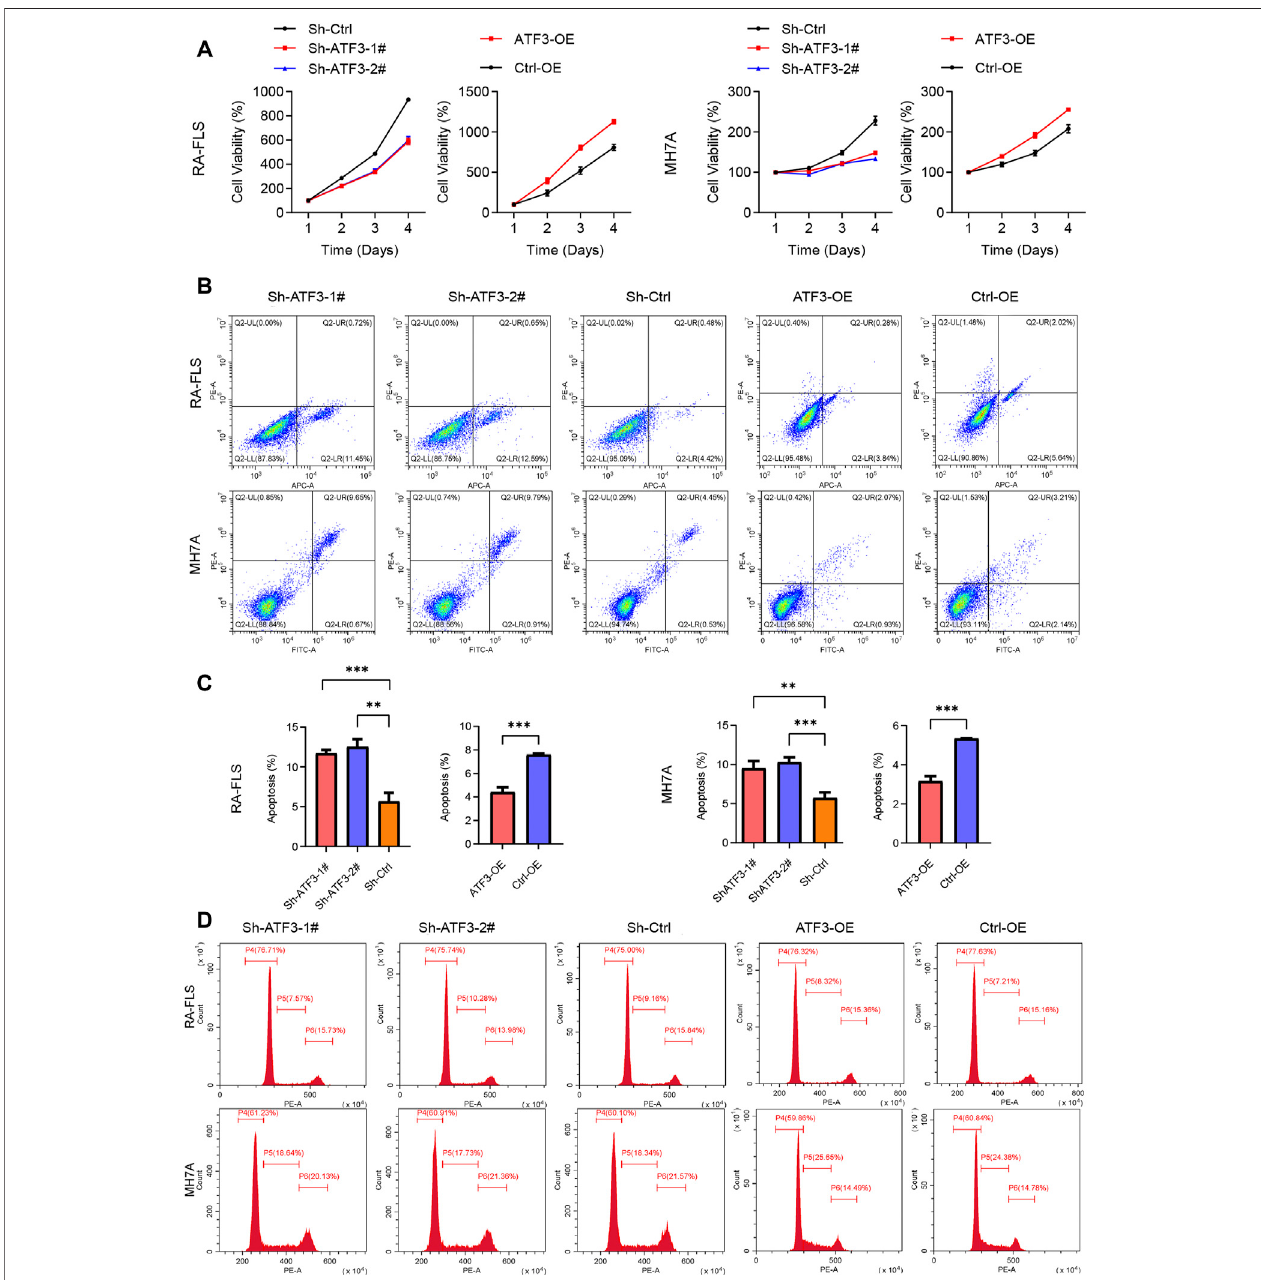
FIGURE9| ImpactofknockdownandoverexpressedATF3oncellviability,apoptosis,andcellcycleinrheumatoidarthritis fi broblast-likesynoviocyte(RA-FLS)and MH7A. (A) TheresultsofCellCountingKit-8(CCK-8) assayrevealedthatthecellviabilityintheSh-ATF3groupwaslowerthaninSh-Ctrlgroup,andthoseintheATF-OE group were higher than in the Ctrl-OE group (mean ± SD, n (cid:1) 3). (B) Flow cytometry was performed to analyze cell apoptosis. The typical image of apoptosis in RA-FLS and MH7A. (C) The results of apoptosis rate showed that Sh-ATF3 induced apoptosis in RA-FLS and MH7A, while ATF3-OE inhibited apoptosis in them (mean ± SD, n (cid:1) 3). (D) Flow cytometry was performed to analyze cell cycle. The typical image of cell cycle in RA-FLS and MH7A. t -Test was performed to analyze the statistical difference. ** p < 0.01, *** p < 0.001.